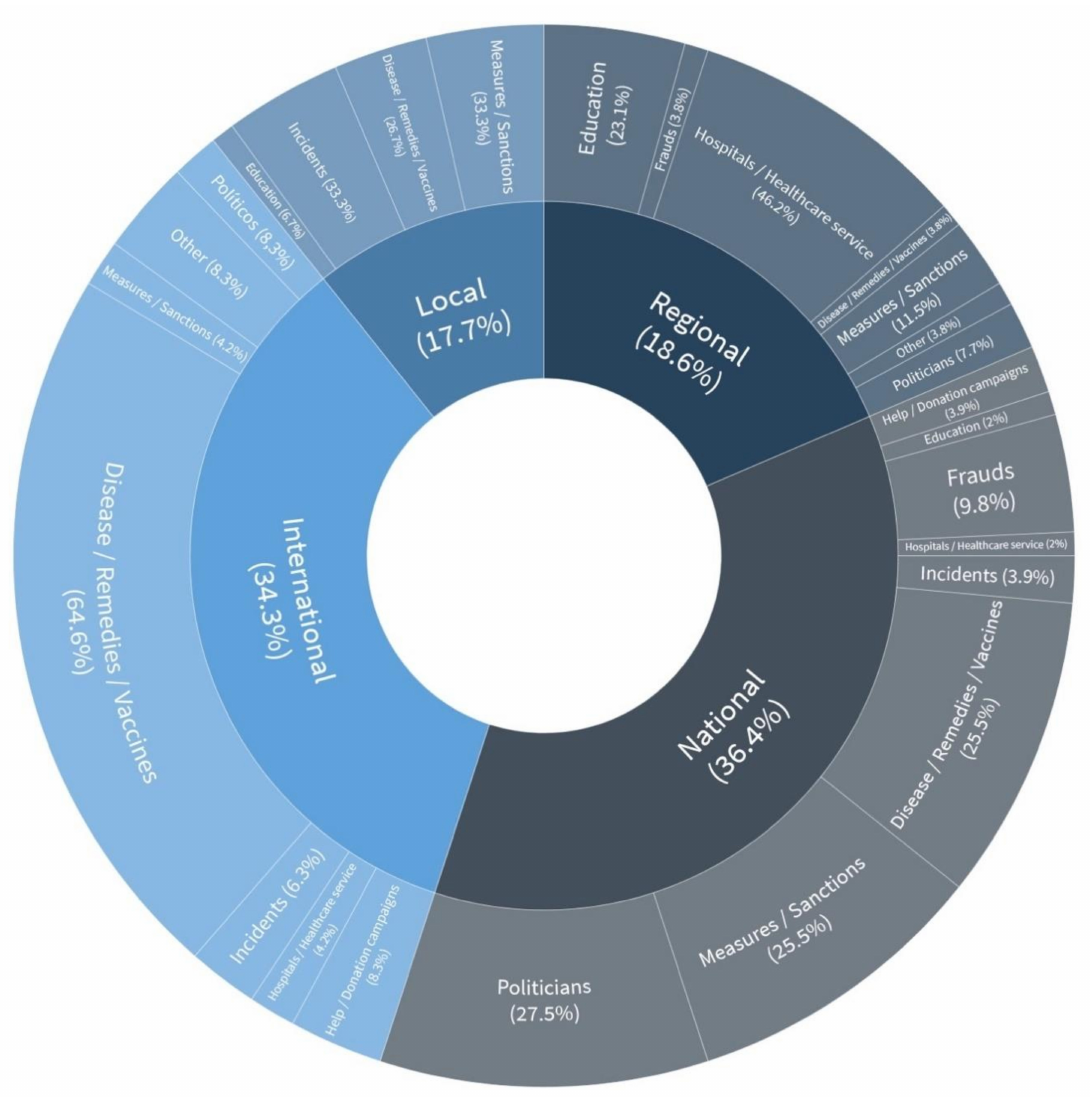
Figure 1. Disinformation by themes. Authors’ own